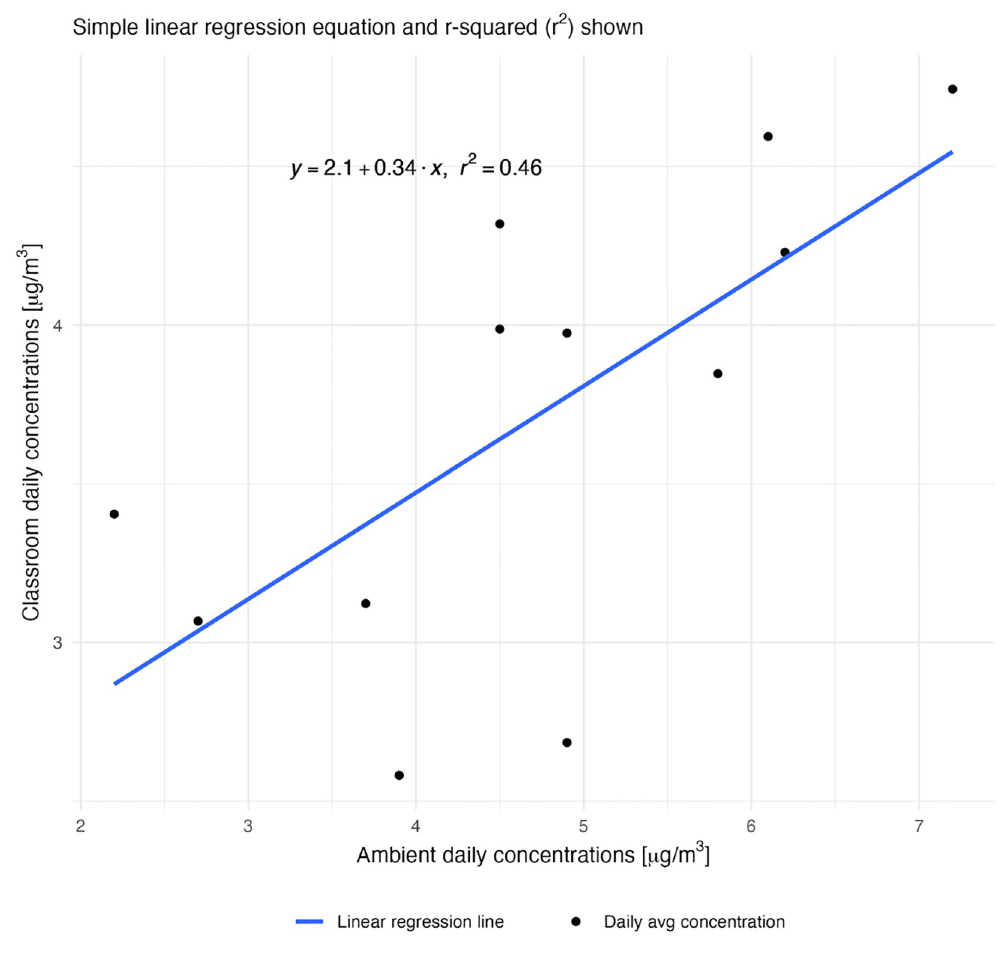
Fig 1. Ambient vs. classroom daily average PM 2.5